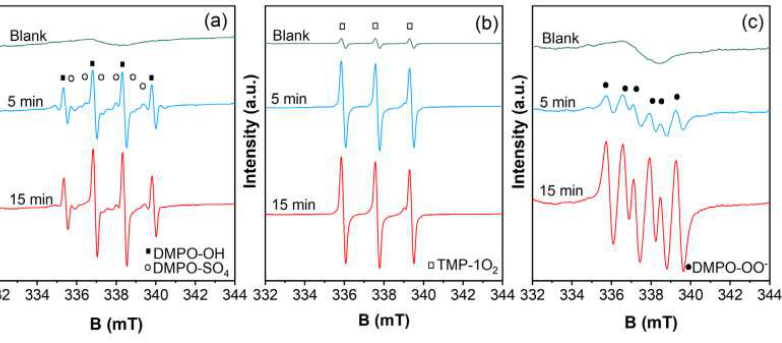
Figure 4. EPR spectra of CuO@CNT/PDS: ( a ) •OH and SO 4•− , ( b ) 1 O 2 , ( c ) O 2•− . Conditions: PDS = 1.0 mM, CuO@CNT = 0.1 g/L.